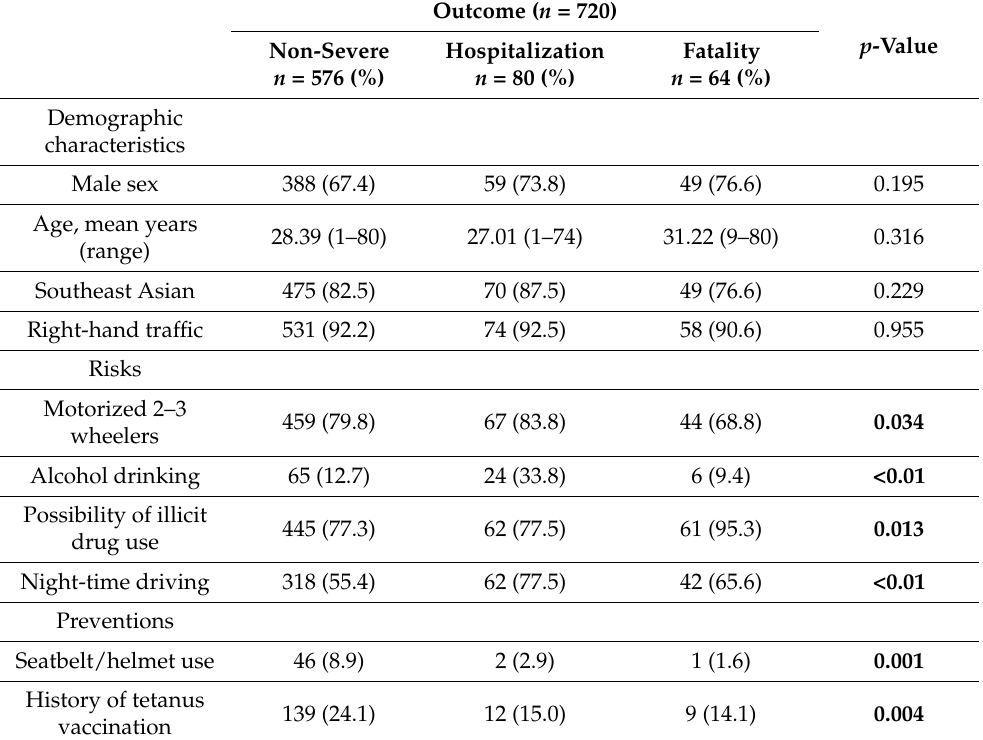
Table 1. Comparison of the characteristics of international travelers with traffic injuries at the Burapha University Hospital emergency center, classified by severity of health outcome ( n = 720). Outcome ( n = 720) p -ValueNon-Severe Hospitalization Fatality n = 576 (%) n = 80 (%) n = 64